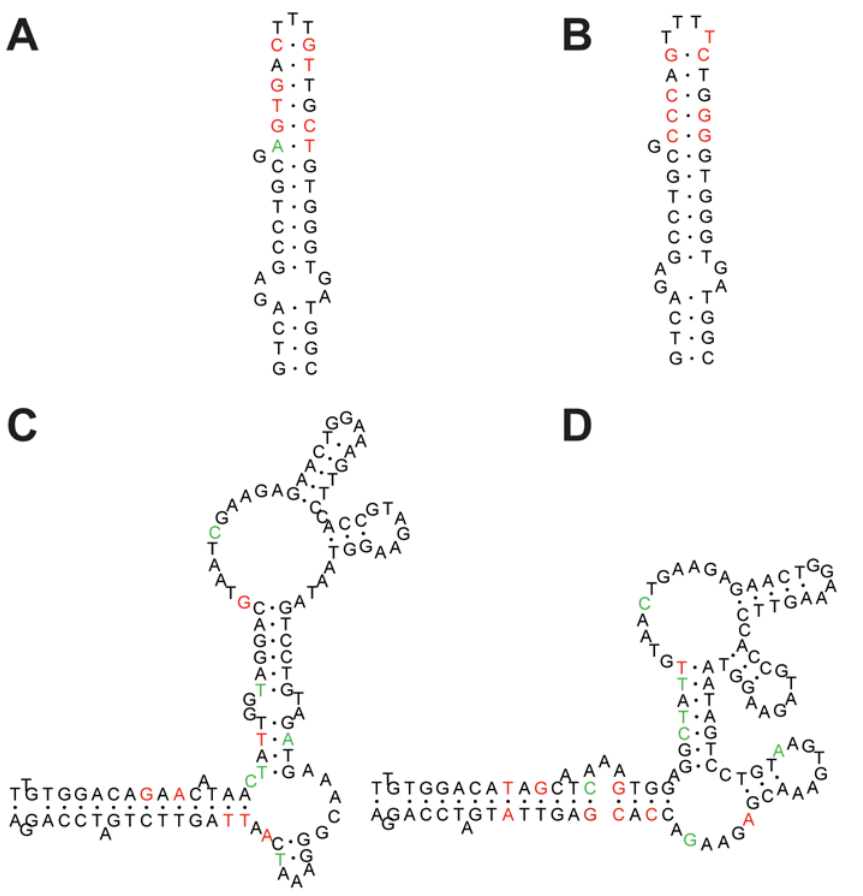
Figure 1. Conservation of 2 u structure by complex rearrangement of base pairing and substitutions in rrn23S of Nocardiafarcinica (A and B) and Clostridiumperfringens (C and D). Nucleotides related to substitutions are highlighted in red and indels in green. Segments of rrn23S of Nocardia farcinica shown correspond to positions 620 through 659 of rrnC23S . The segments of rrnC23S (A) and rrnB23S (B) differ by 9 positions, including one indel and eight substitutions. Segments of rrn23S of Clostridium perfringens shown correspond to positions 292 through 406 of rrnH23S . The segments of rrnH23S (C) and rrnD23S (D) differ by 22 positions, including 13 indels and 8 substitutions. doi:10.1371/journal.pone.0005437.g001 PLoS ONE |